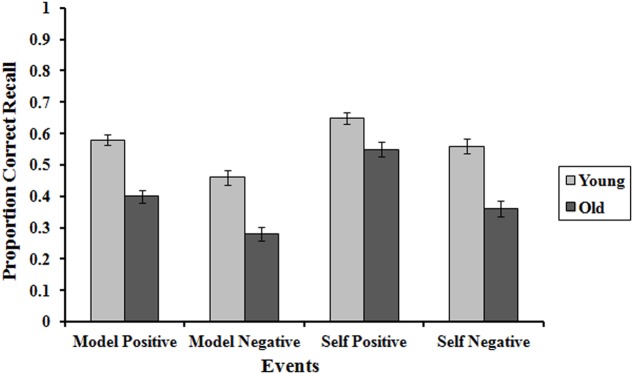
Proportion of correct recall of the positive and negative future events of both the model and own experiences in young and older adults. Error bars represent standard errors.